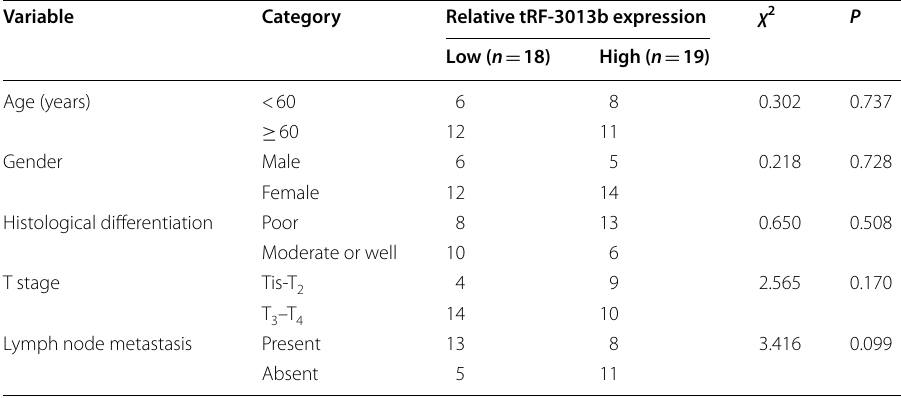
Table 2 Correlation between clinicopathological status and expression of tRF-3013b